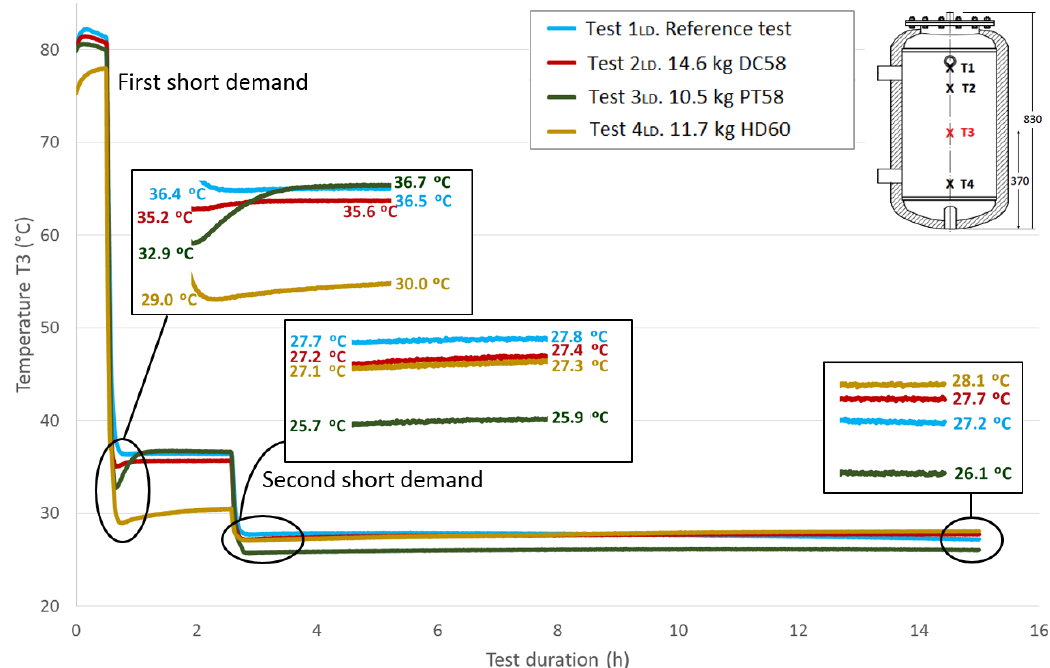
Figure 14. Medium bottom height water temperature ( T 3) inside the tank during the two shorts demands experiment. (dimensions are in mm).